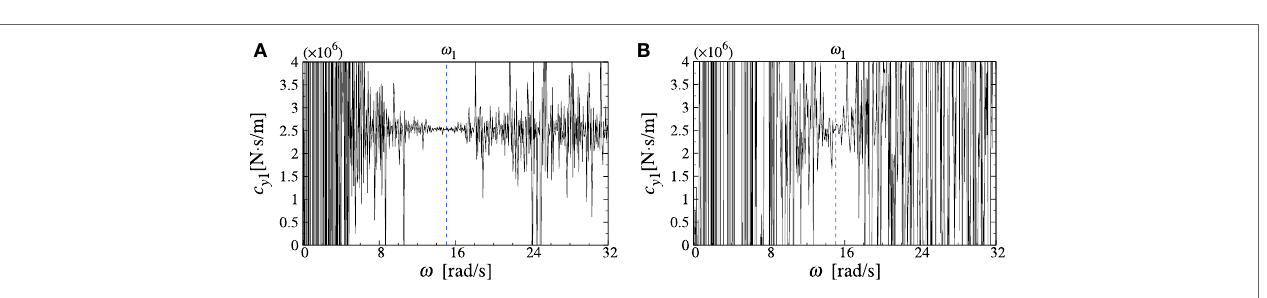
FIGURE 7 | Identification result of lateral damping coefficient (model A), (A) noise level 0%, (B) noise level 5%.